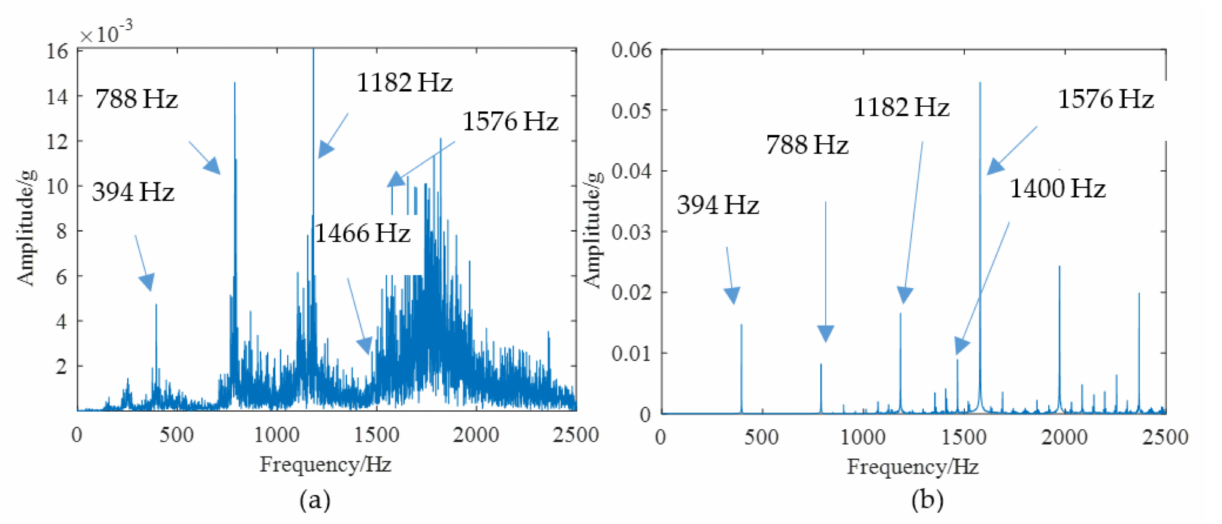
Figure 11. The spectrum of normal system: ( a ) Experimental, ( b )